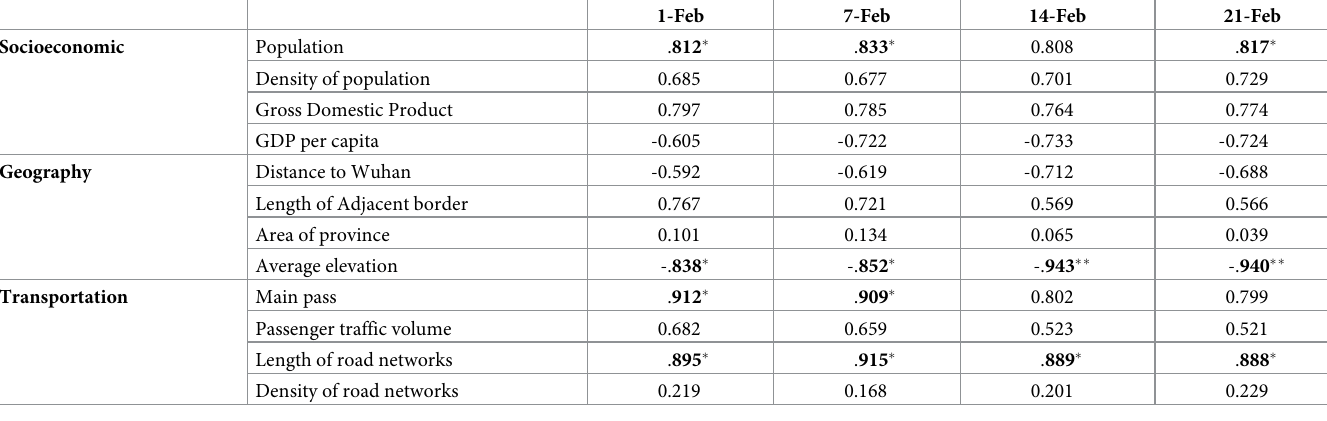
Table 4. Coefficient of Correlation analysis between NCCC and SGT